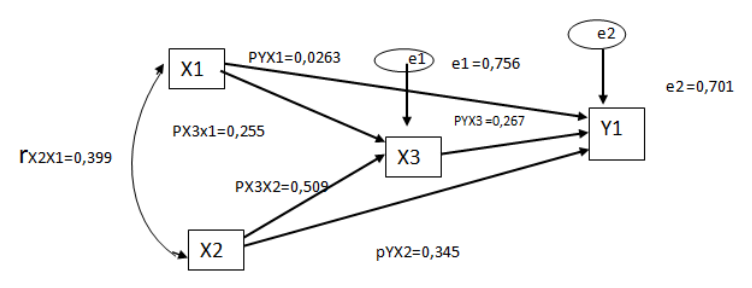
Figure 4. Model of effect test results among research variables